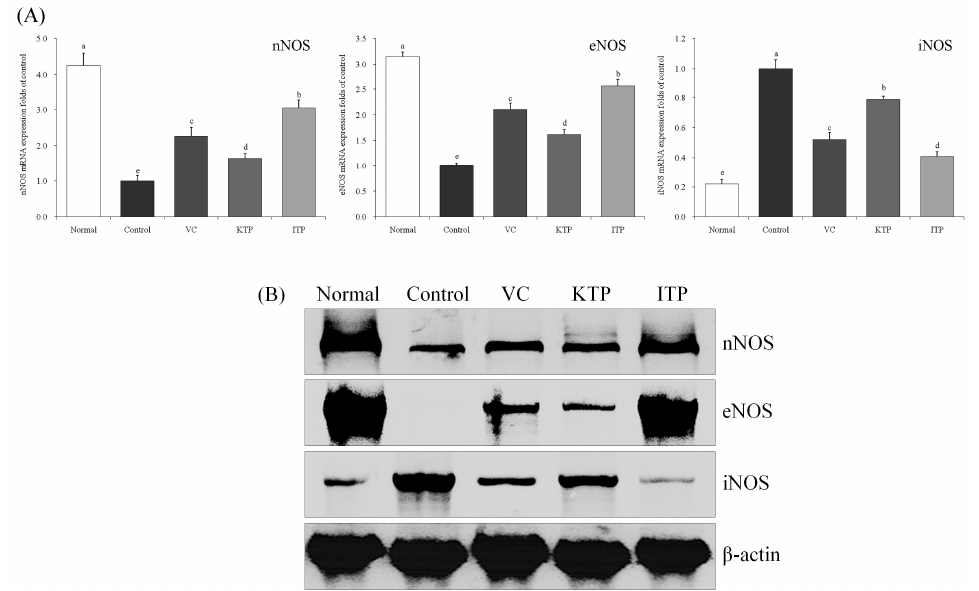
Figure 4. Expression of mRNA ( A ) and protein ( B ) for nNOS, eNOS and iNOS in liver of mice. a–e Mean values with different letters in the same bar represent significant differences ( p < 0.05) according to Duncan’s multiple-range test. VC: vitamin C (200 mg/kg body weight); KTP: Kuding tea polyphenols (200 mg/kg body weight); ITP: insect tea polyphenols (200 mg/kg body weight).